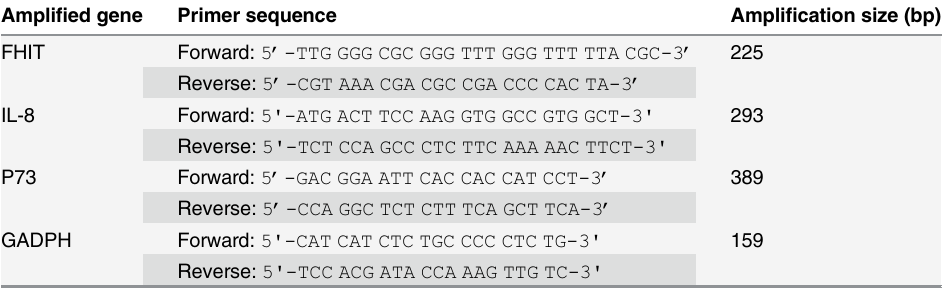
Table 1. Sequences of the primers used for amplification of FHIT, IL-8 and P73.